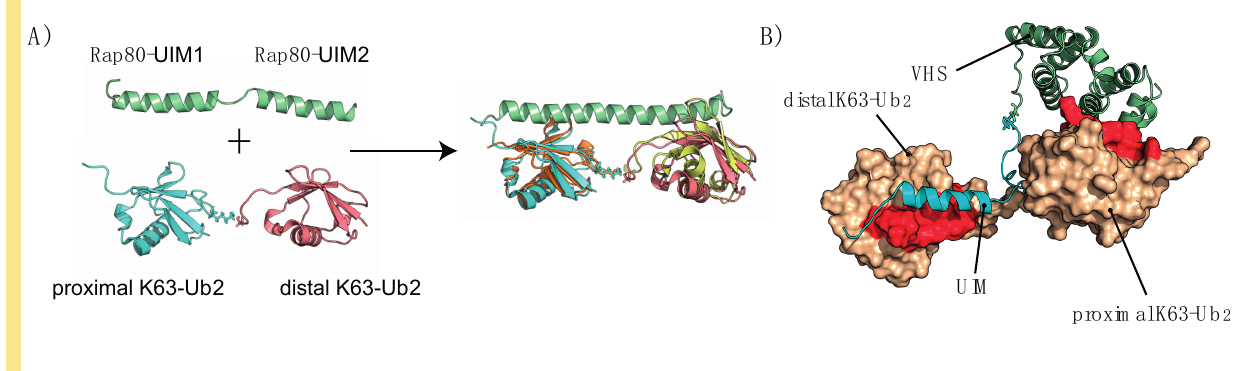
Figure I. ( A ) Structure of the Rap80 UIM1-UIM2 /K63-Ub complex. The UIM1 and UIM2 domains are connected by 2 a flexible linker (left), which adopts a helical structure upon binding to K63-Ub . The NMR structure of the 2 complex (PDB code 2RR9, pink and K63-Ub cyan) and the X-ray structure (PDB code 3A1Q, yellow and K63- 2 Ub orange) are aligned with respect to the Rap80 structure. ( B ) Model of the structure of the STAM2 VHS- 2 UIM /Lys63-Ub complex obtained by NMR and showing the strong specificity of the VHS and UIM domains for the 2 proximal and distal Ub,